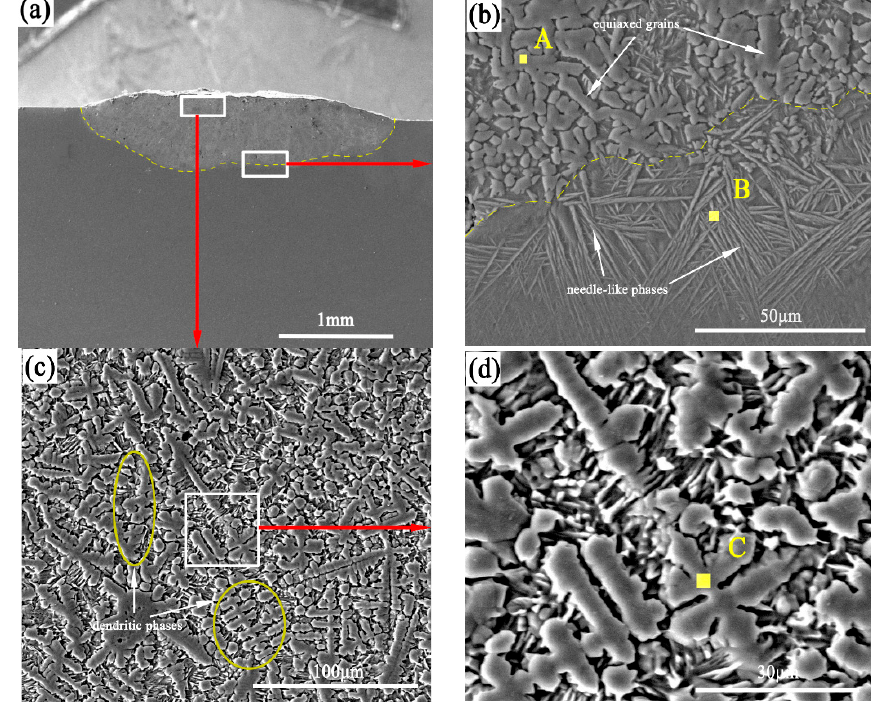
Figure 11. SEM image of transverse cross-section of TiBCN-ceramic-reinforced Ti-based coating. ( a ) Cross-sectional macromorphology of the coating; ( b ) the interface region; ( c ) top of coating; and ( d ) the magnified image of the quadrangle in ( c ).